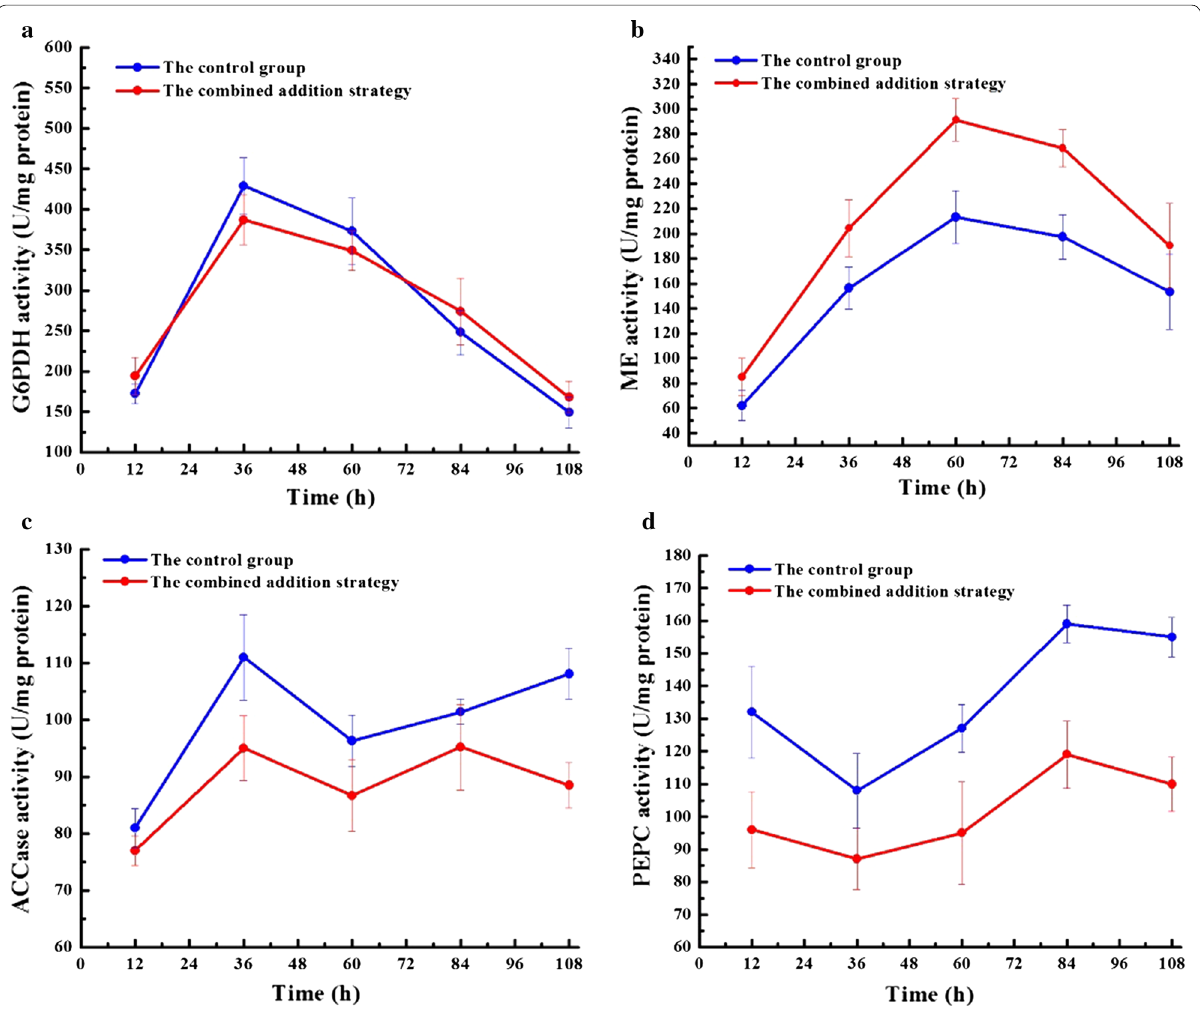
Fig. 3 Comparison of key enzymes involved lipid biosynthesis between the control group and the combined addition strategy in a 5‑L bioreactor: a G6PDH activity, b ME activity, c ACCase activity, d PEPC activity. Values and error bars represent the means and standard deviations from triplicate